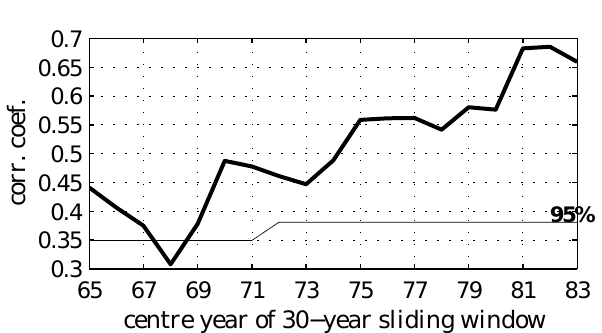
SON − 1 in Guinea. The values at the top right-hand corner present the corre- lation coefficients obtained between the two raw ( r = 0 . 63) and two detrended series ( r = 0 . 5, in brackets). Data